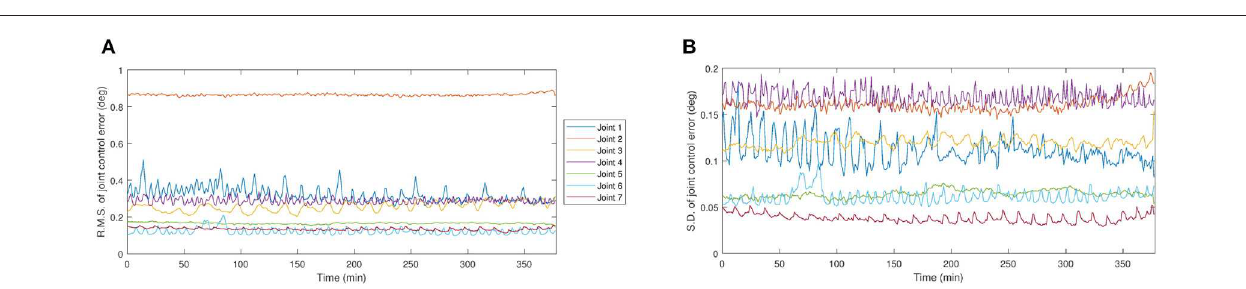
robot. Attempts to reboot, remaster, and the passage of time have been unsuccessful in recovering robot movement: this failed component was permanently destroyed.